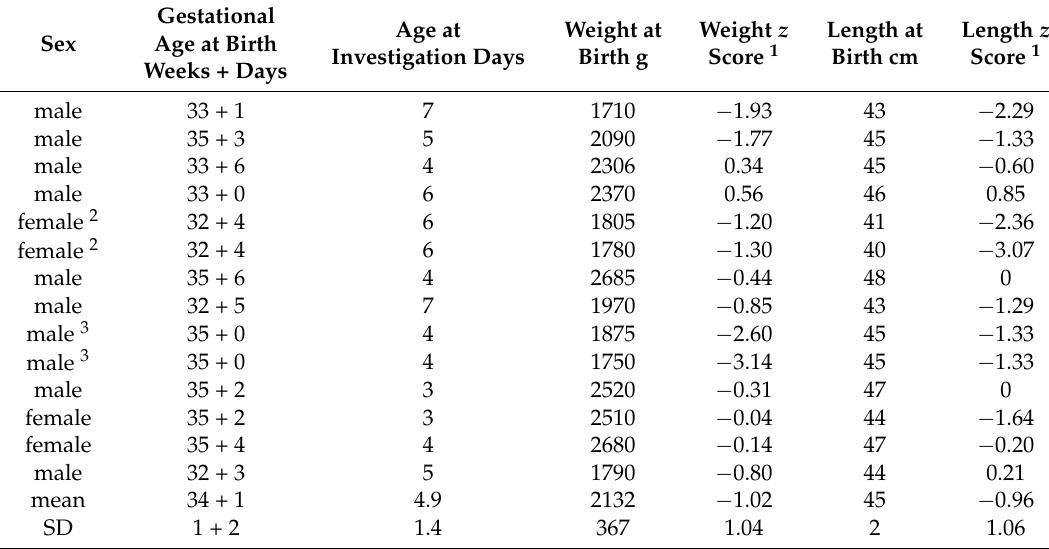
Table 1. Characteristics of infants in the study.